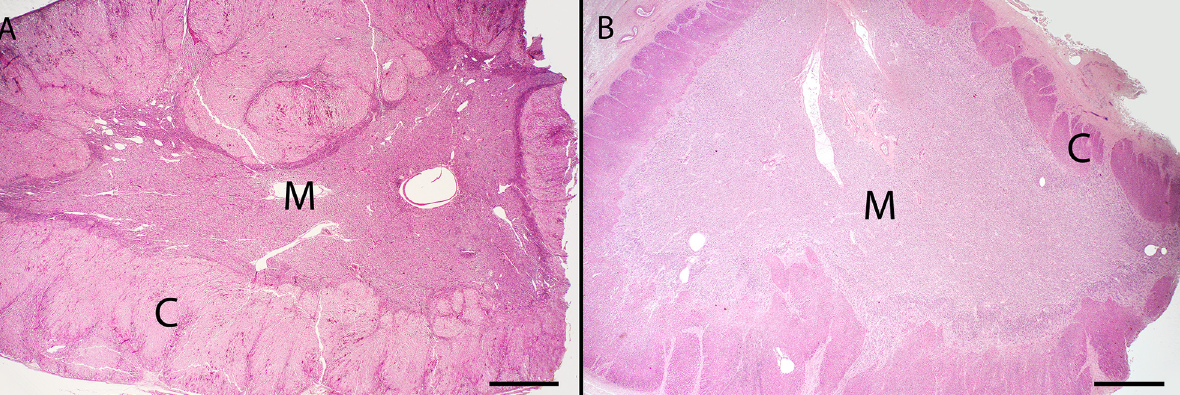
Fig 1. Hematoxalin and eosin stained sections of adrenal glands from common bottlenose dolphins ( Tursiops truncatus ) C = cortex; M = medulla. A. Normal adrenal gland from a subadult male dolphin that stranded fresh dead along the west coast of Florida in 2003. Bar = 1 mm. B. Adrenal gland from a subadult male dolphin that stranded in Barataria Bay, Louisiana in 2011. Note the thin adrenal cortex, especially in the fasciculata region. Bar = 1mm.